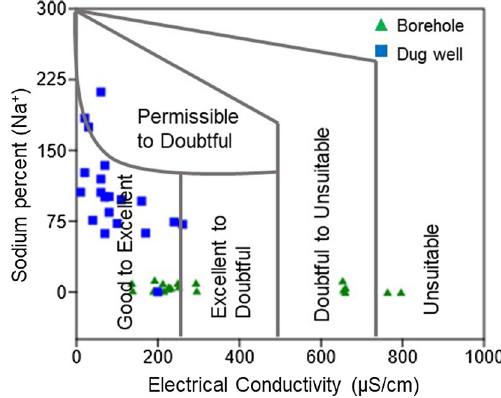
Fig. 13 Wilcox diagram showing groundwater classification for irri- gation use